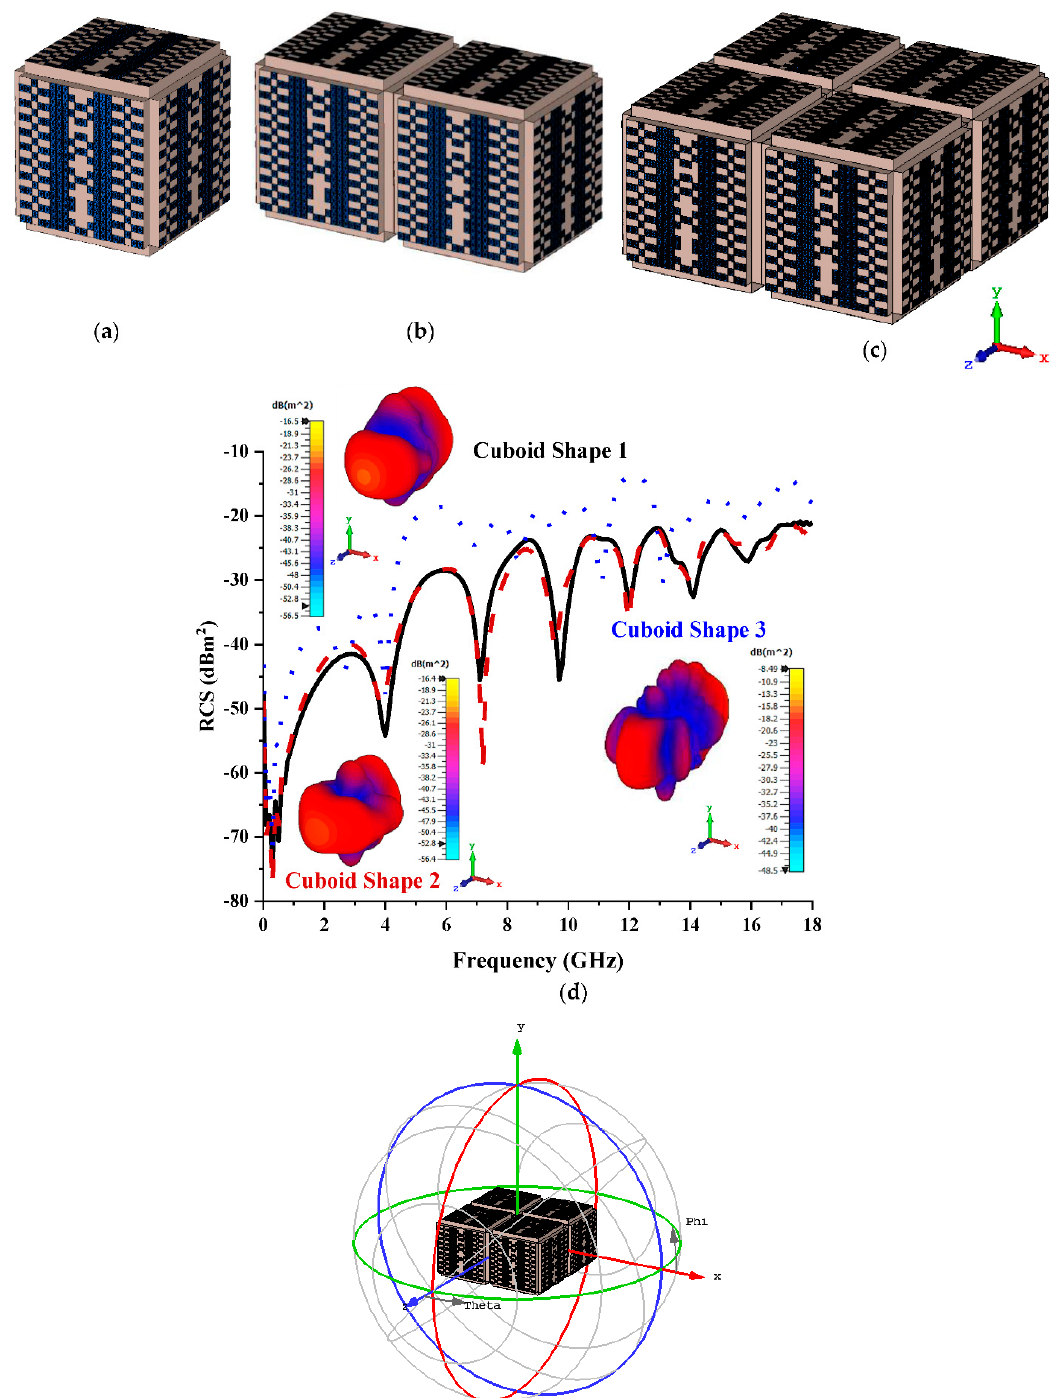
Figure 10. Twenty lattices: ( a ) Cuboid Shape 1; ( b ) Cuboid Shape 2; ( c ) Coding Shape 3; ( d ) monostatic RCS and bistatic scattering pattern at 15 GHz; ( e ) polarisation